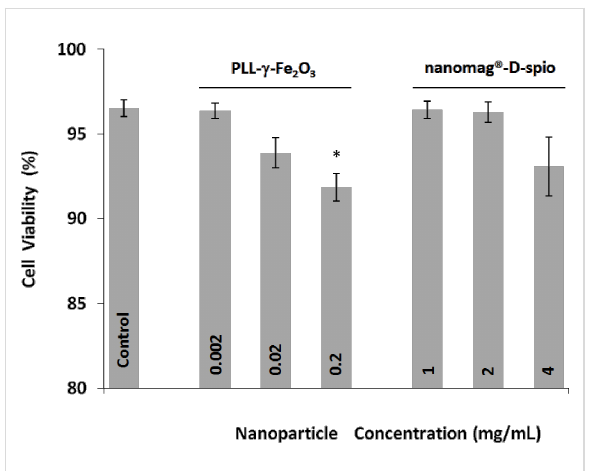
Figure 5: PLL- γ -Fe 2 O 3 nanoparticles had low NSC cytotoxicity. Flow cytometry analysis showed the influence of nanoparticle cytotoxicity on the survival of NSCs labeled with PLL- γ -Fe 2 O 3 and nanomag ® -D-spio nanoparticles ( N = 4). The asterisk indicates a statistically significant difference ( P < 0.05) versus Control.